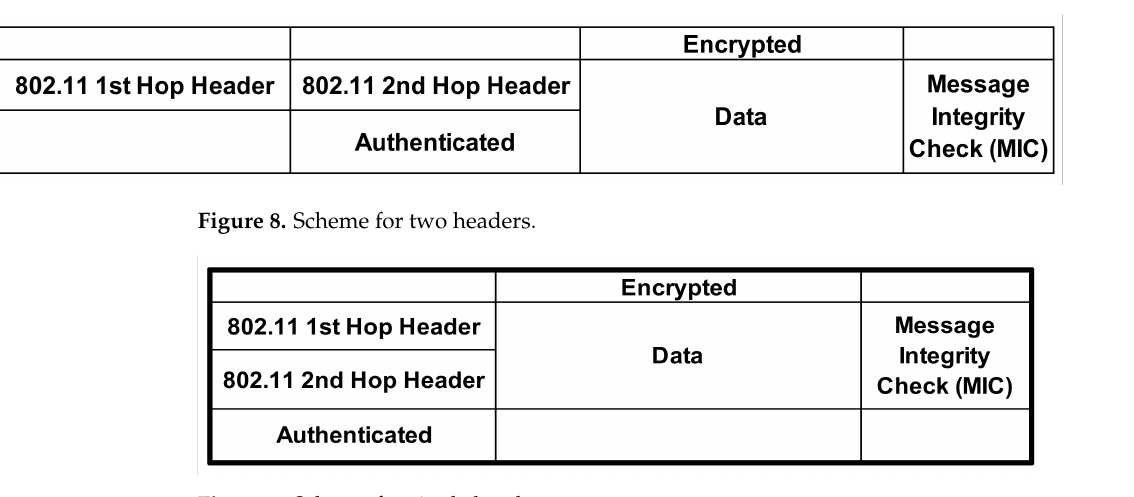
Figure 9. Scheme for single